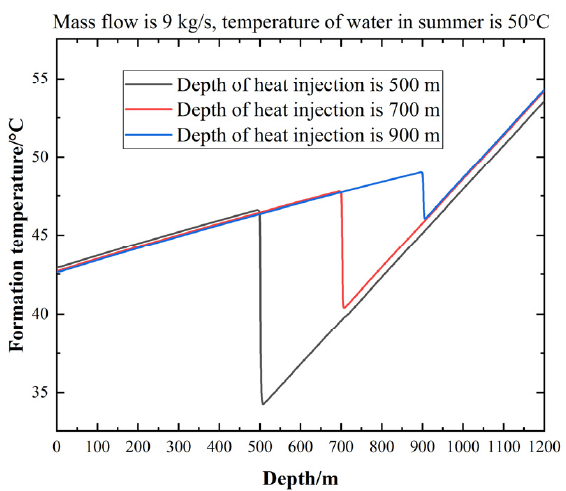
Figure 13. Formation temperature around the well under different depths of the check valve.